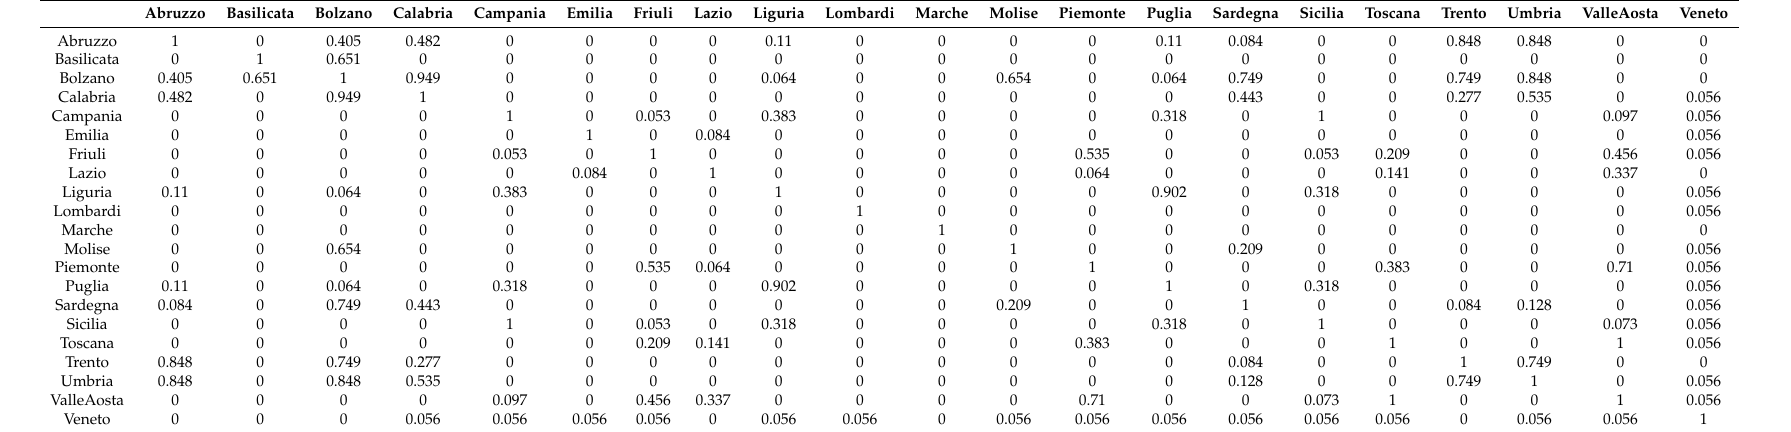
Table A58. Similarity values of Swabs network in the third